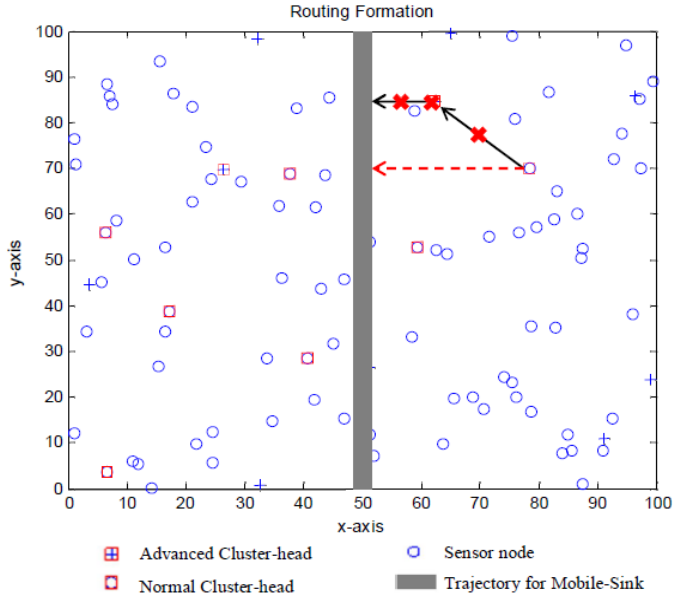
Figure 6. Maintain the routing